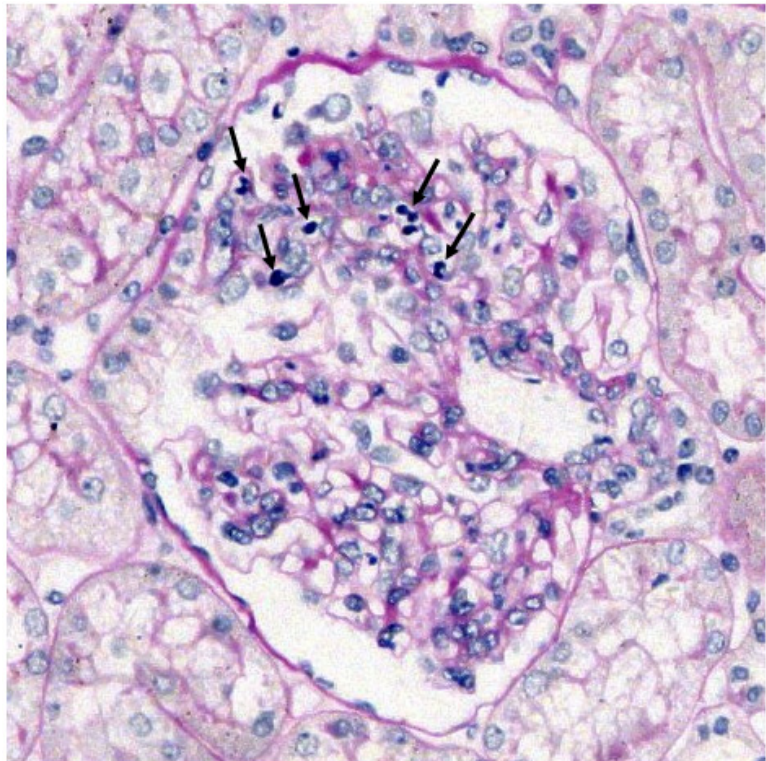
Figure 1. Example of a glomerulus of a patient with IgAVN exhibiting mesangial proliferation and glomerular leukocytes. Representative leukocytes are marked by arrows. PAS stain, magnification 400×.